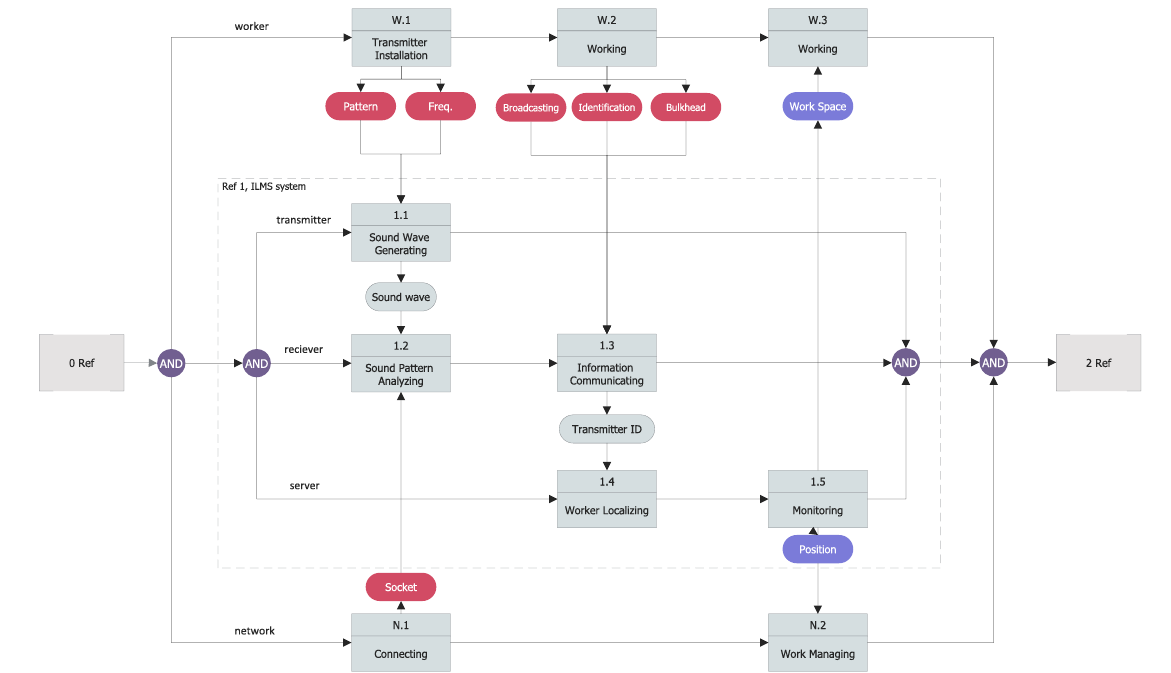
Figure 4. The logical architecture of the ILMS system.